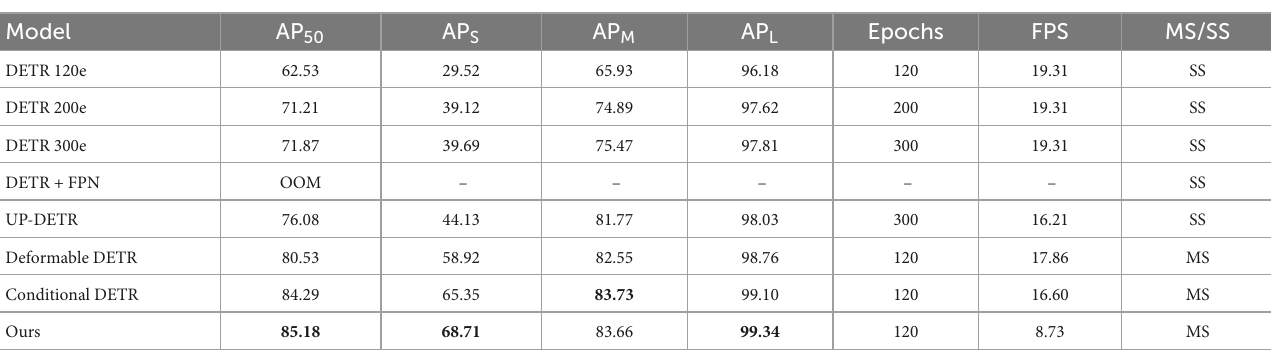
TABLE 1 The effects of attentional